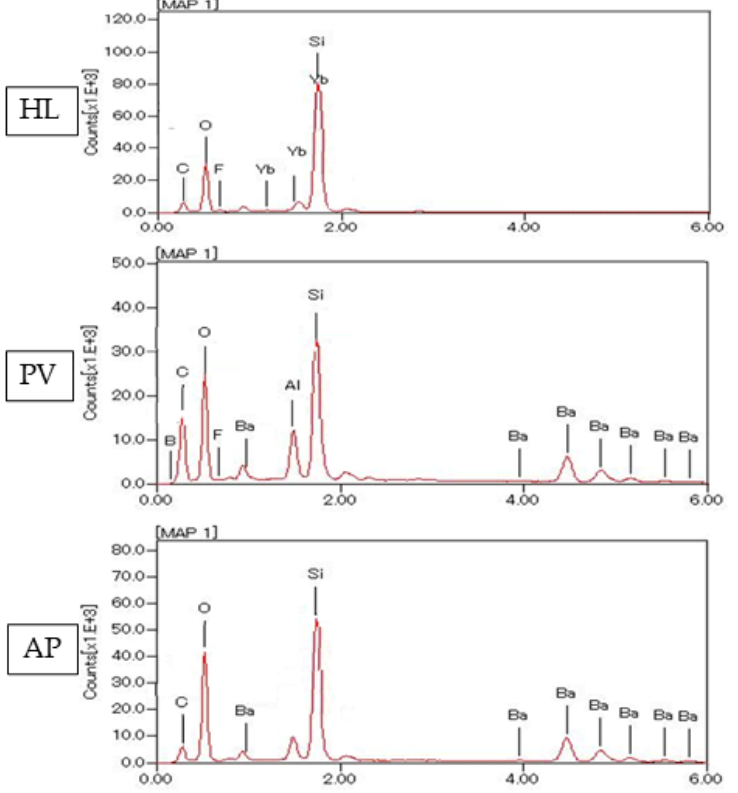
Figure 5. Elements identified by EDX spectroscopy microanalysis for novel experimental HL resin cement, PV resin cement, and AP resin composite.